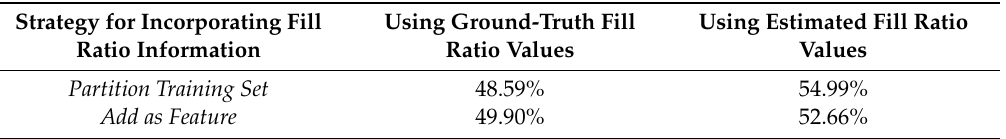
Table 7. Volume estimation accuracy enhancement using fill ratio information (baseline value with no fill ratio information: